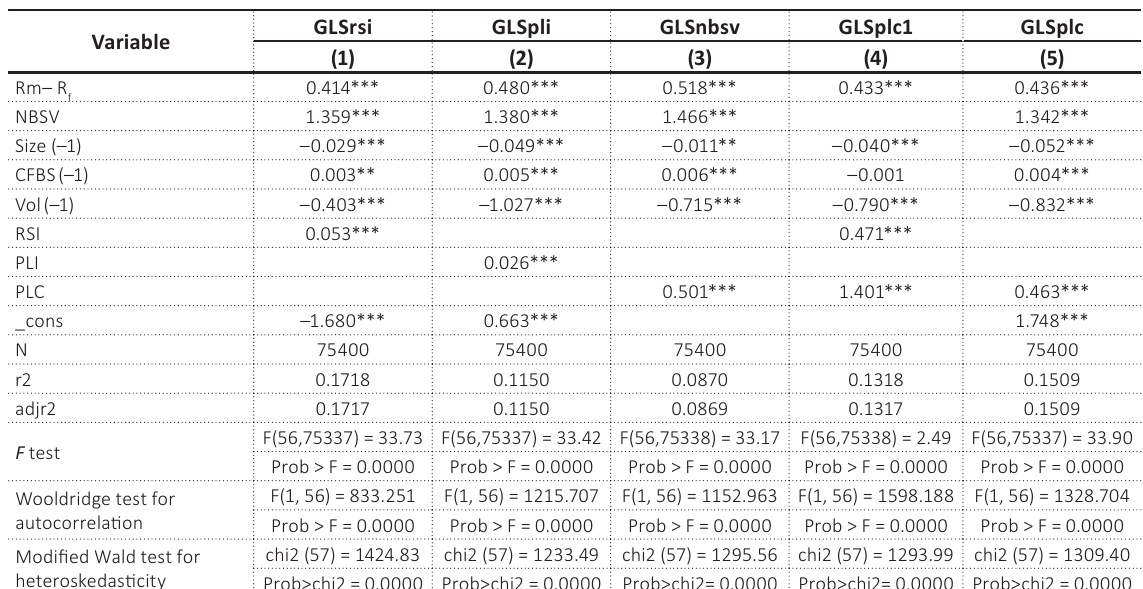
Table 5. Regression results according to